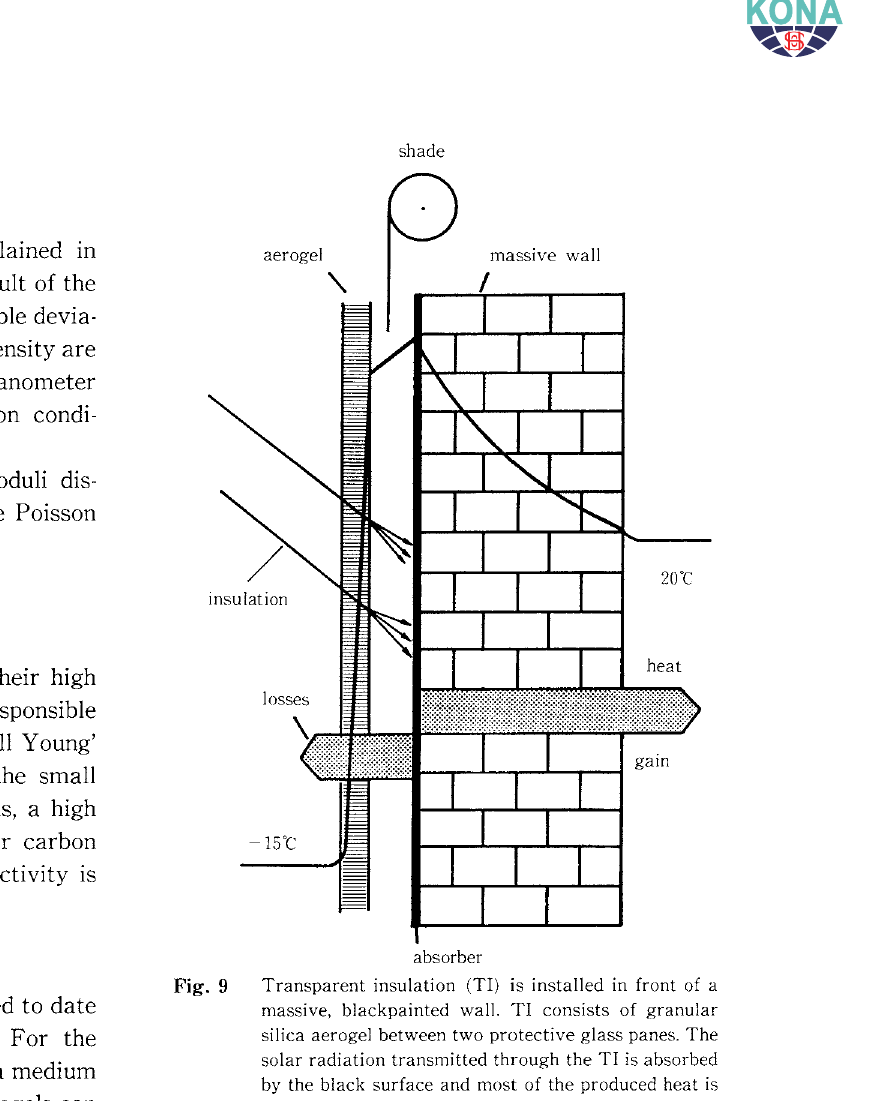
Transparent insulation (TI) is installed in front of a massive, blackpainted wall. TI consists of granular silica aerogel between two protective glass panes. The solar radiation transmitted through the TI is absorbed by the black surface and most of the produced heat is transferred into the building, only little heat is lost. To prevent overheating, a shading device is